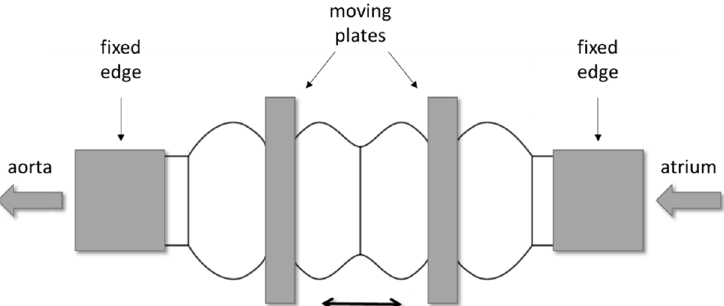
Figure 2. Example of the mechanism for the actuation of the ventricular chamber: two rigid plates, anchored to the valvular planes, are electro-mechanically operated to compress and expand the central compartment.